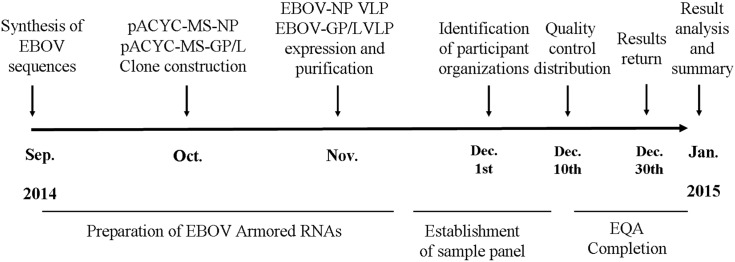
A schematic map of the experimental procedure.